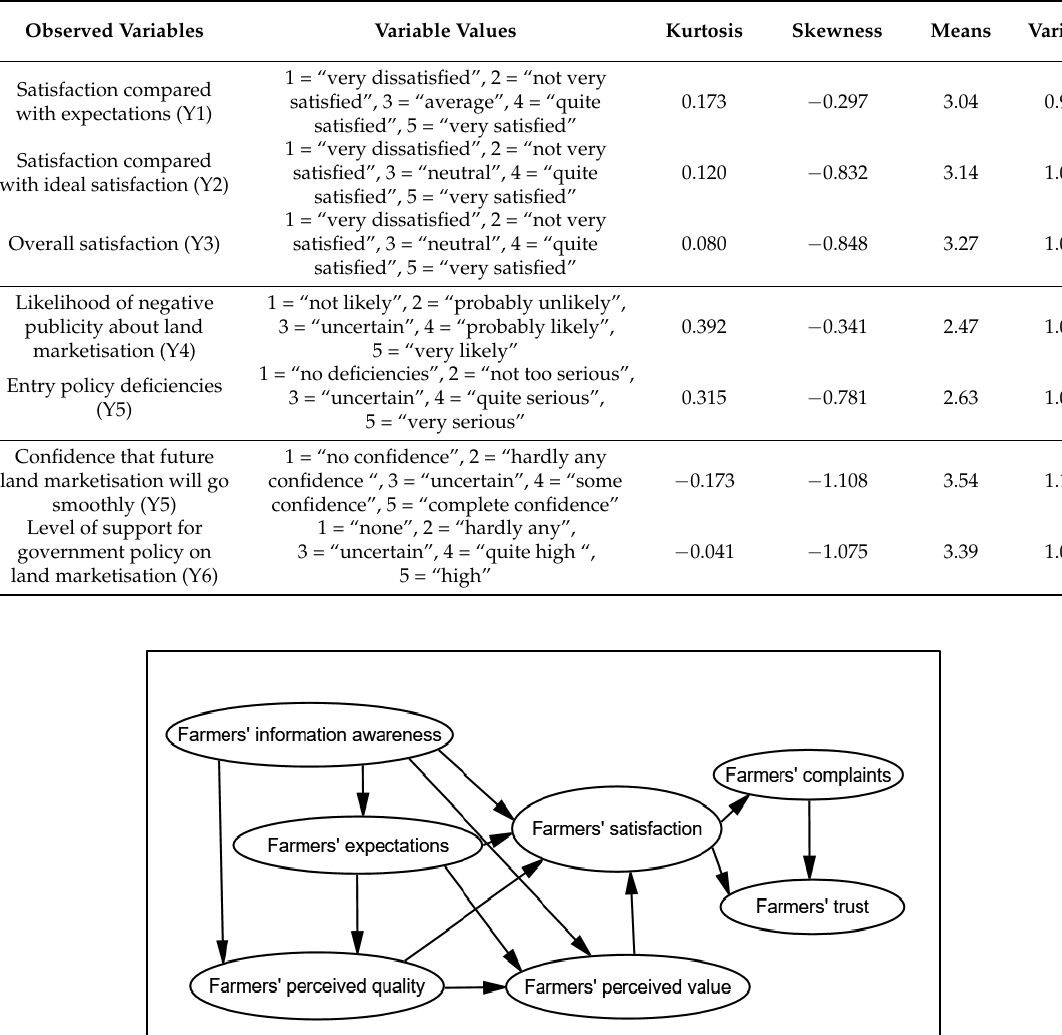
Figure 1. Diagram of the pathway for implementing the research hypotheses. Table 1. Description of the model variables.